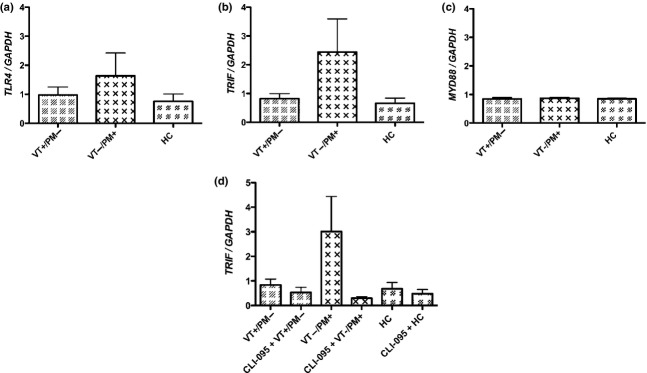
HTR-8 cells treated with VT−/PM+ IgG but not HTR-8 cells treated with VT+/PM− IgG increase TLR4 and TRIF transcript levels. HTR-8 cells were treated with 100 μg/mL pooled IgG from VT+/PM− with 78.2GPLU and 44.4SU binding activity, VT−/PM+ with 83.4GPLU and 71.5SU binding activity and HCs with 0GPLU and SU binding. TLR4 (a), TRIF (b) and MyD88 (c) mRNA expression at 6 hr was measured by qRT-PCR. TRIF mRNA expression in HTR-8 cells pre-treatment with the TLR4 inhibitor CLI-095 before treatment with 100 μg/mL pooled IgG from VT+/PM−, VT−/PM+ and HCs was also measured (d). The mean ± SEM of quantitative analysis from four independent experiments is shown. Results are expressed as fold change of either TLR4, TRIF or MyD88/GAPDH, relative to untreated cells. No statistically significant differences were found by one-way anova.